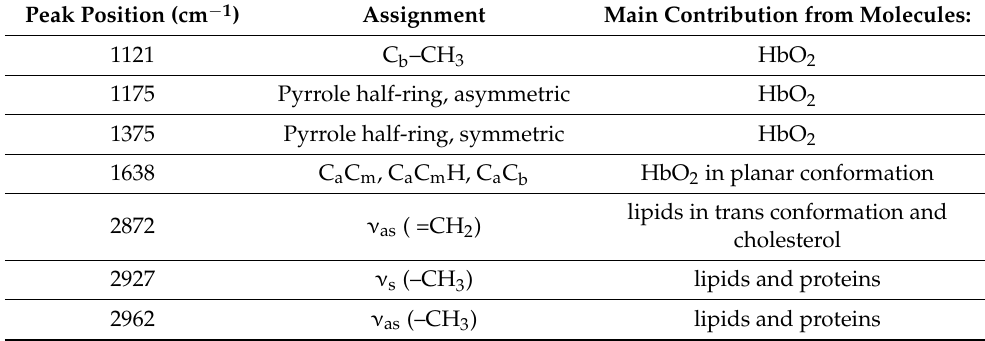
Table 1. SERS peak assignment